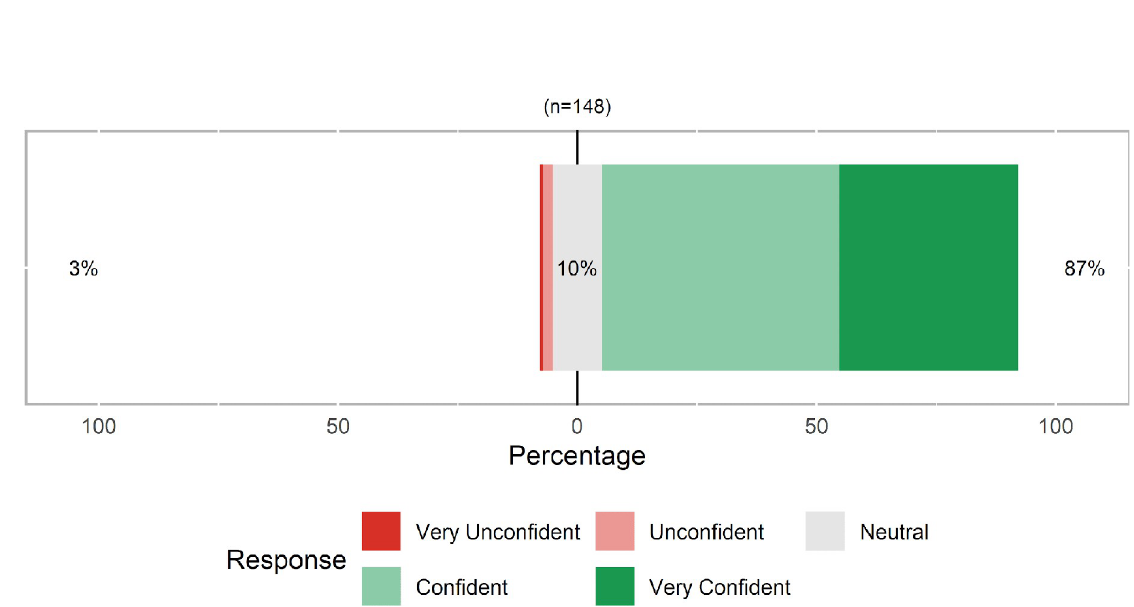
Fig 2. Overall participant confidence in at-home self-collection of saliva, oropharyngeal swab and dried blood spot specimens for SARS-CoV-2-related testing after specimen collection, United States, April